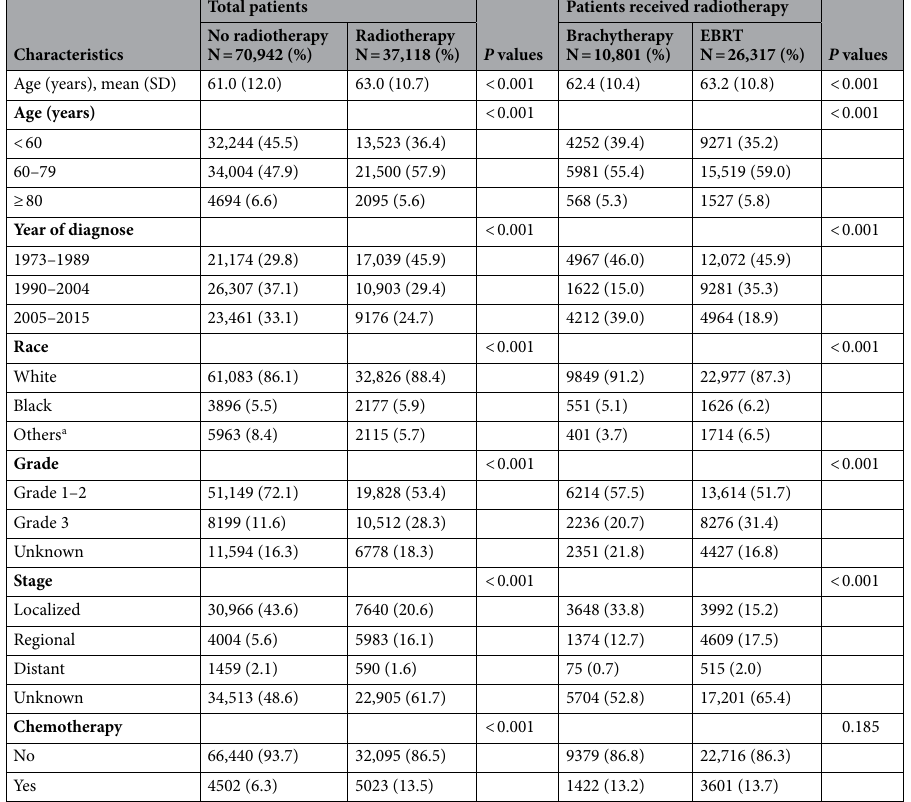
Table 1. Baseline characteristics of endometrial cancer patients (N = 108,060). EBRT, External beam radiotherapy. a Including Asian and American Indians.